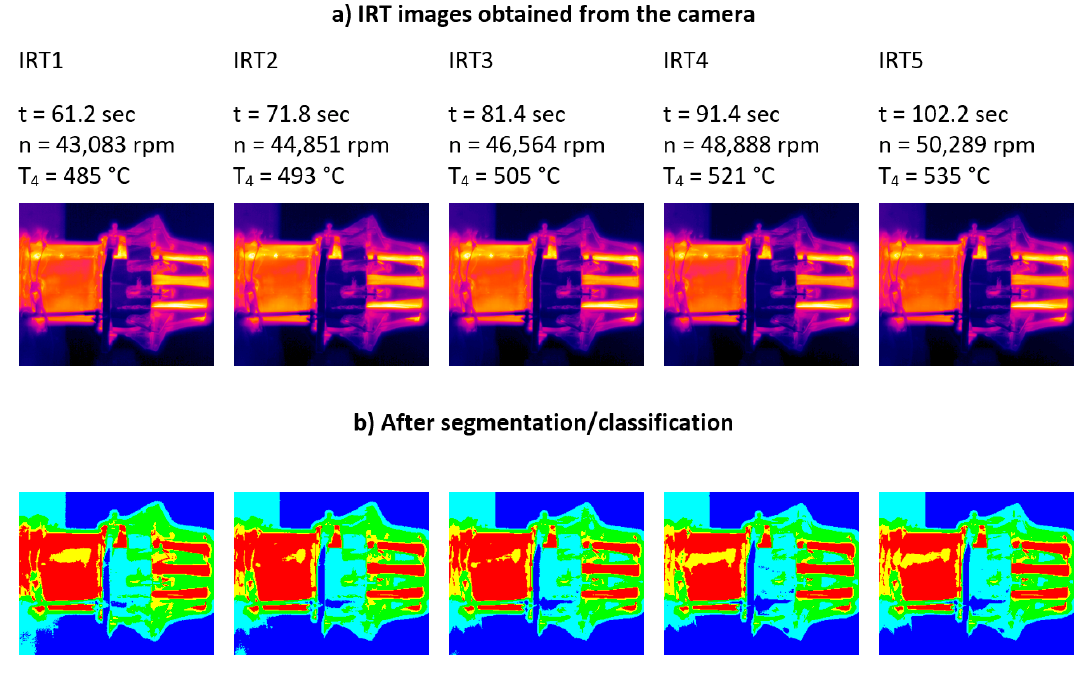
Figure 15. The segmented thermal images produced by the Kohonen map.